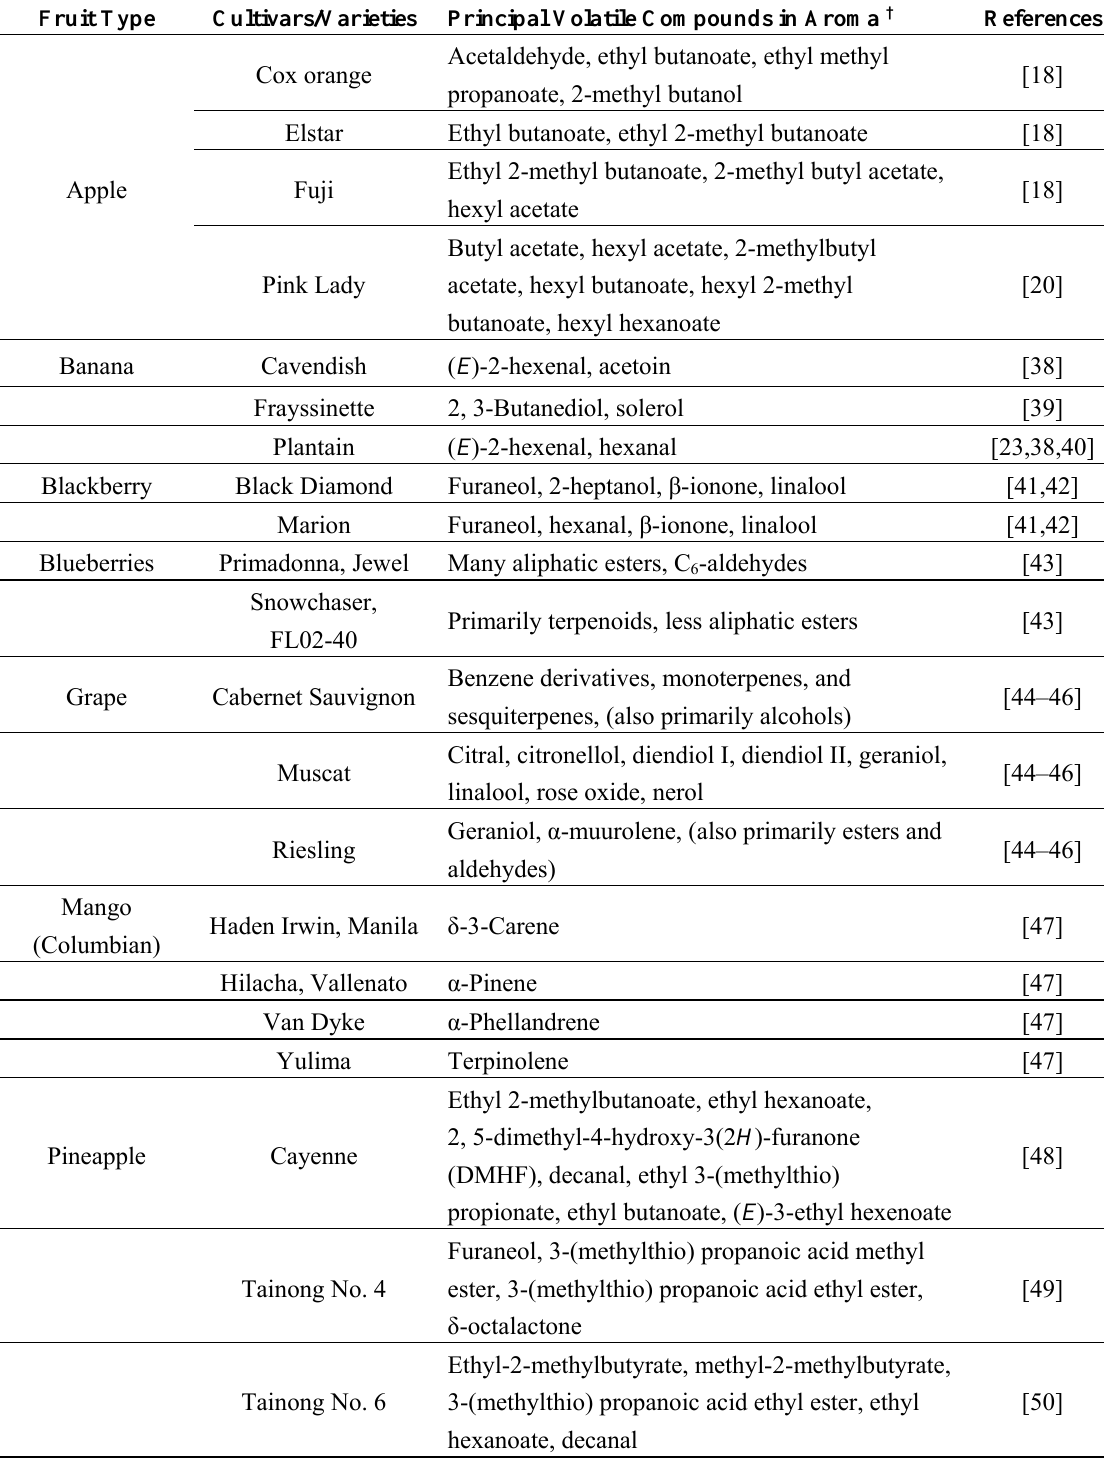
Table 2. Principal volatile compounds comprising the distinctive aromas of different fruit cultivars. Fruit